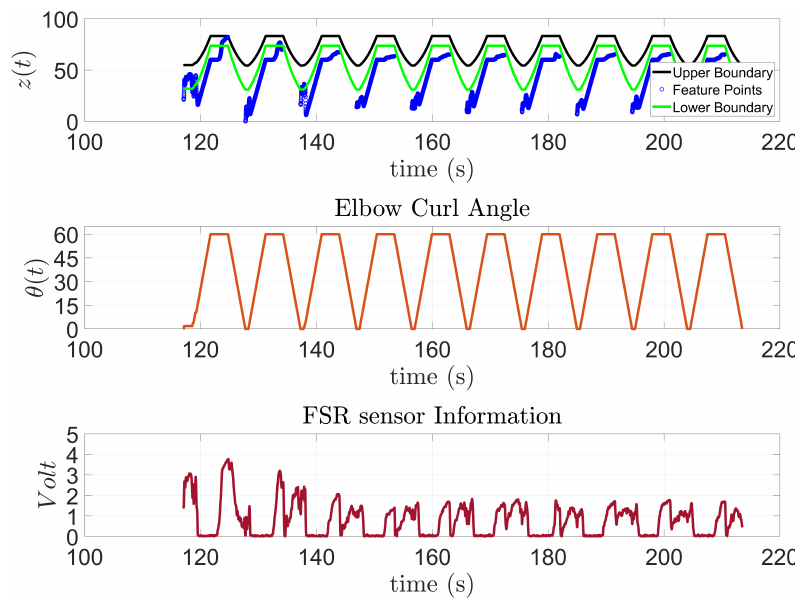
Figure 19. Subject 5: AAN through elbow flexion